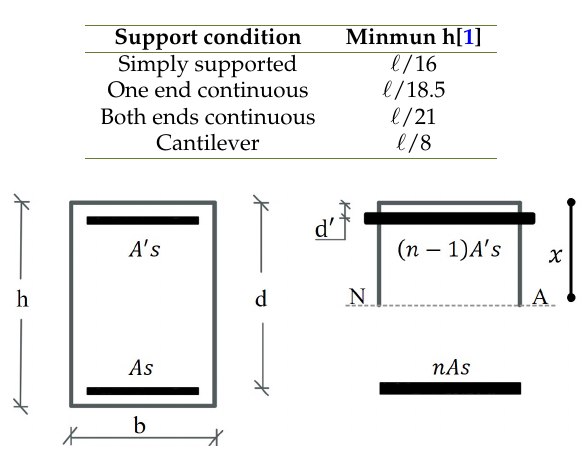
Table 1. Minimum depth of nonprestressed beams [1]